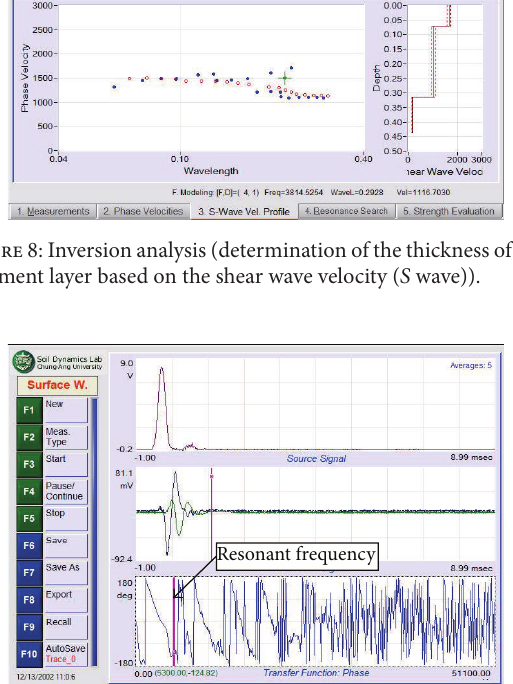
Figure 7: Phase velocity dispersion curve.